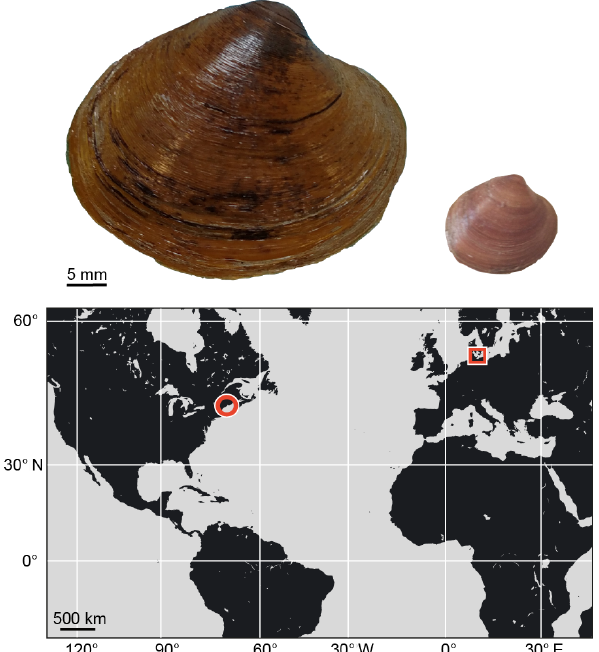
Figure 1. Shell of adult Arctica islandica used in the temperature experiment (top) and juvenile from the Baltic Sea used in the food experiment (bottom). The map indicates the localities where the two sets of shells were collected: Jonesport, Maine (circle), and Kiel Bay (square).